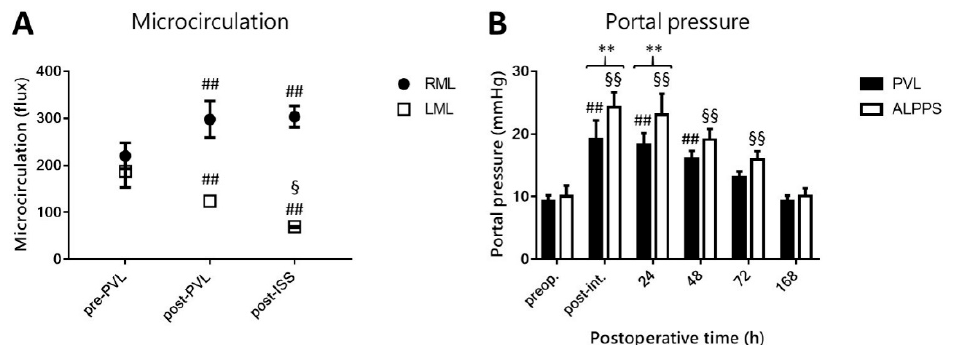
Figure 4. Effect of portal vein ligation (PVL) and associating liver partition and portal vein ligation for staged hepatectomy (ALPPS) on the liver microcirculation and portal pressure. The microcirculatory flow measurements ( A ) were performed preoperatively (pre-PVL), after PVL (post-PVL), and after the in-situ split in ALPPS (post-ISS) in the non-ligated right median lobe (RML) and the ligated left median lobe (LML) ( n = 6 per time point per group). ## p < 0.001 versus preoperative value (pre-PVL); § p < 0.05, §§ p < 0.001 versus post-PVL value (post-PVL). The portal pressure measurements ( B ) were performed preoperatively (preop.), immediately after intervention (post-int.) and at 24 h, 48 h, 72 h, and 168 h after PVL and ALPPS ( n = 6 per time point per group). ** p < 0.001 versus PVL; ## p < 0.001 PVL versus corresponding controls (preop.); § p < 0.05, §§ p < 0.001 ALPPS versus corresponding controls (preop.). Statistical analysis was performed with a two-way ANOVA and Tukey’s post hoc test. Data are presented as mean ± 1 standard deviation (SD).